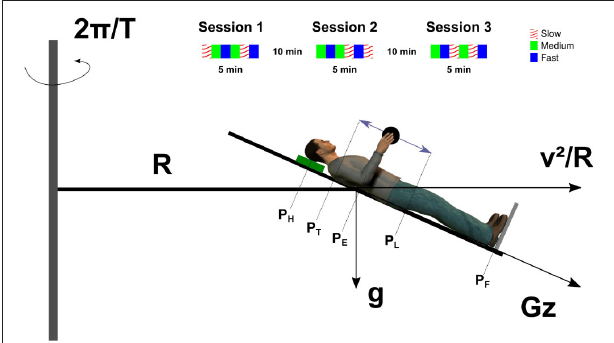
FIGURE 1 | Unscaled sketch of the participant in the SAHC. The leftward gray vertical thin rectangle represents the axis of rotation about which the centrifuge rotates at an angular rate of 2 π T . The bed was tilted by − 24 degrees and positioned such that the elbow joint (P E ) was at distance R from the axis of rotation. The participant was supine on the bed, her/his head resting on a cushion (green rectangle) and the feet supported by a metallic plate (gray line). The vector Gz is the gravitoinertial resultant between the centripetal acceleration (horizontal vector) and the gravitational acceleration (vertical vector). The double arrow represents the trajectory of the object (black disk) in the sagittal plane. The upper inset illustrates a complete experiment composed by three sessions. Each color corresponds to a different pace condition (see legend). Symbols: P H , head; P T , top of trajectory; P E , elbow; P L , lower part of trajectory; and P F ,